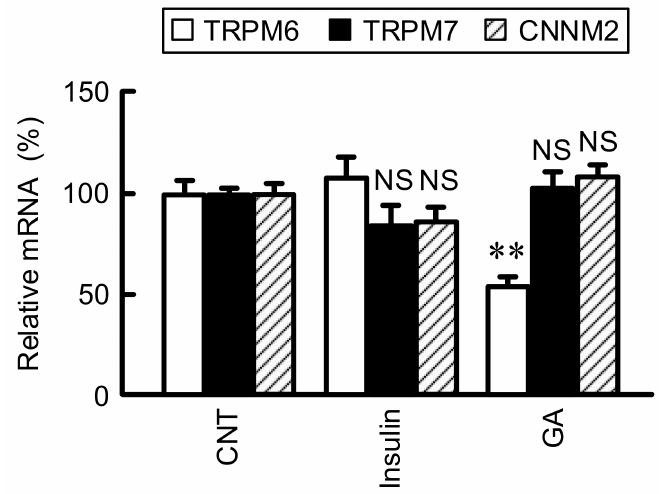
Figure 1. Effects of insulin and GA on the expression of Mg 2+ transporters. The cDNA was prepared from total RNA of NRK-52E cells treated with vehicle (CNT), 10 nM insulin, or 500 µ g/mL GA for 6 h. Real time PCR was carried out by primers for TRPM6, TRPM7, CNNM2, and β -actin. The expression levels of TRPM6, TRPM7, and CNNM2 were normalized by β -actin, and were represented as percentage of CNT. n = 3–4. ** p < 0.01 and NS p > 0.05 compared with